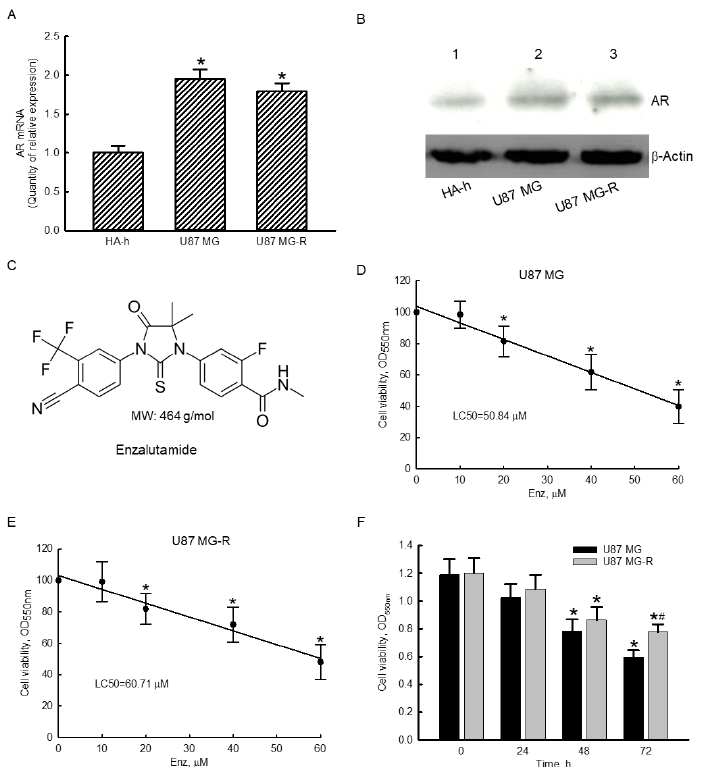
Figure 2. Effects of enzalutamide (Enz) on viabilities of human temozolomide (TMZ)-sensitive U87 MG and TMZ-resistant U87 MG-R glioblastoma cells. Expressions of androgen receptor (AR) mRNA in human HA-h astrocytes, and U87 MG and U87 MG-R glioblastoma cells were measured using a real-time PCR ( A ). Levels of AR were immunodetected (( B ), top panel). β -Actin was analyzed as the internal control (bottom panel). The chemical structure of Enz and its molecular weight are shown ( C ). Human U87 MG ( D ) and U87 MG-R ( E ) glioblastoma cells were exposed to 10, 20, 40, and 60 µ M Enz for 72 h. Cell viability was analyzed using a colorimetric method. The 50% lethal concentrations (LC 50 s) of enzalutamide in human U87 MG and U87 MG-R glioblastoma cells were then calculated. Human U87 MG and U87 MG-R glioblastoma cells were treated with 50 µ M Enz for 24, 48, and 72 h, and cell viability was assayed ( F ). Each value represents the mean ± SEM for n = 6. The symbols * and # respectively indicate that the values significantly ( p < 0.05) differed from the control and U87 MG